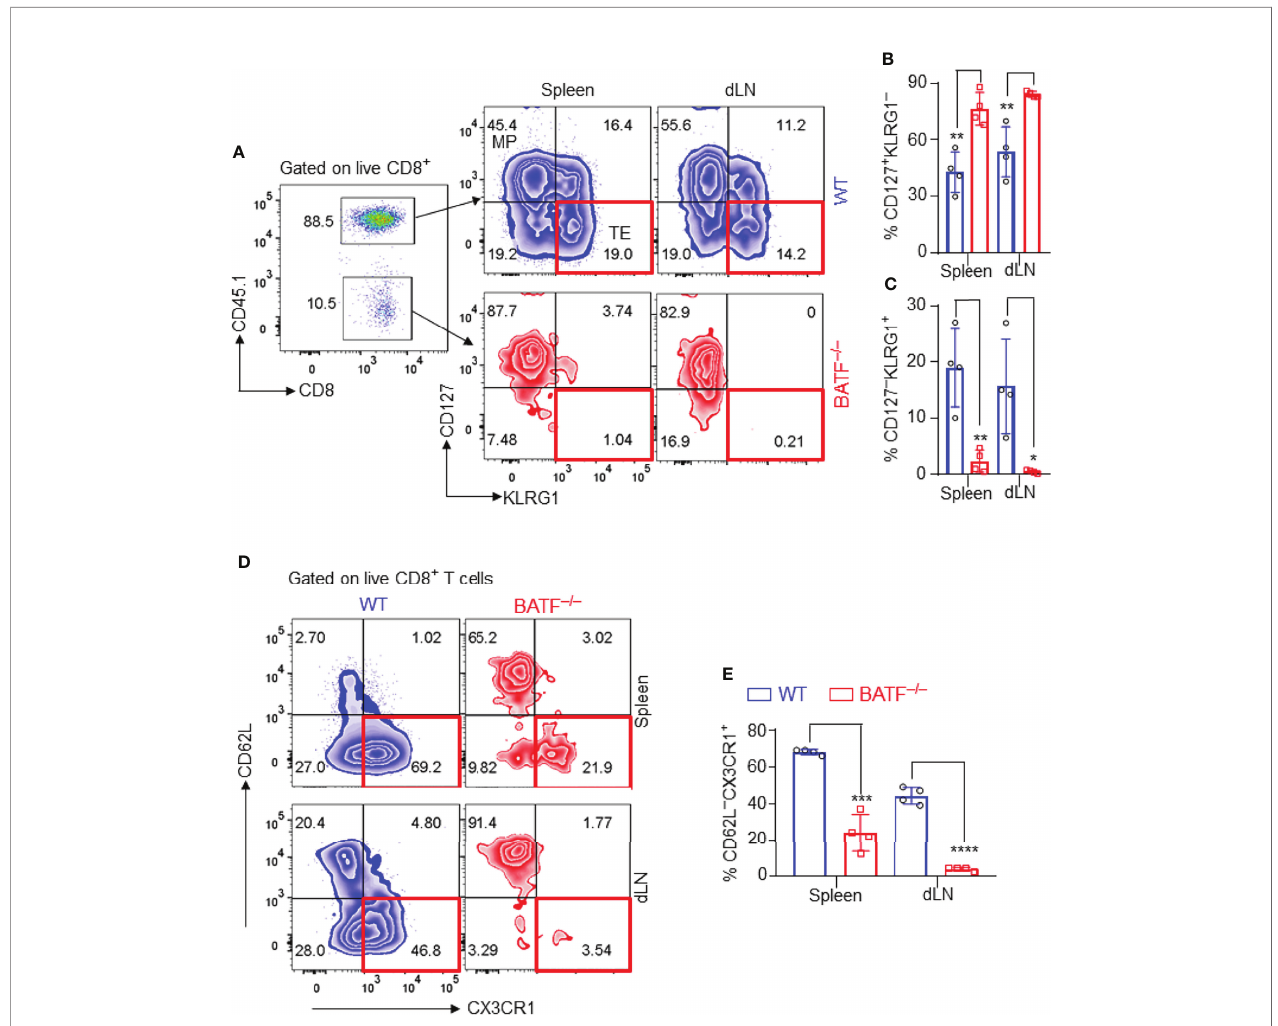
FIGURE 3 | BATF-de fi cient CD8 + T cells fail to differentiate into terminal effector cells in recipients. The effector phenotypes of the transferred CD8 + T cells in B6. Rag1 – / –